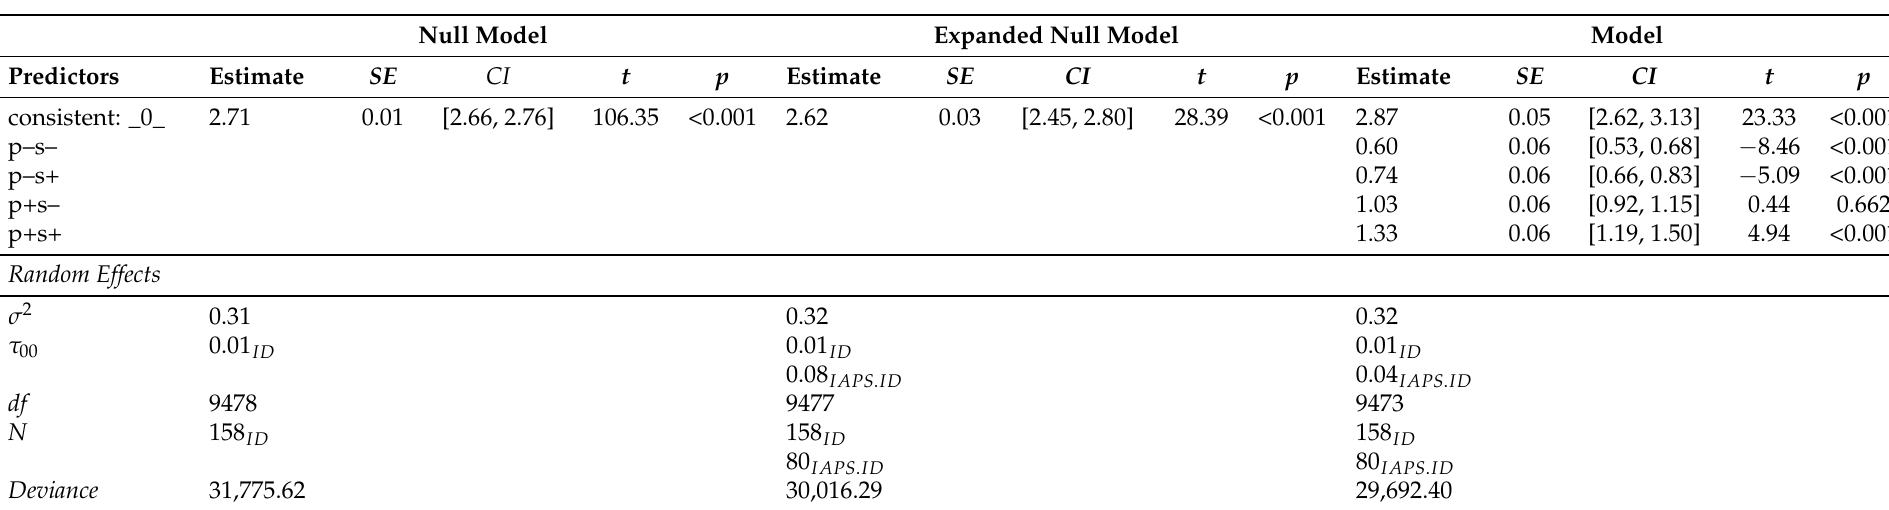
Table A6. Mixed model of the influence of specific stimuli conditions on the emoscale widget